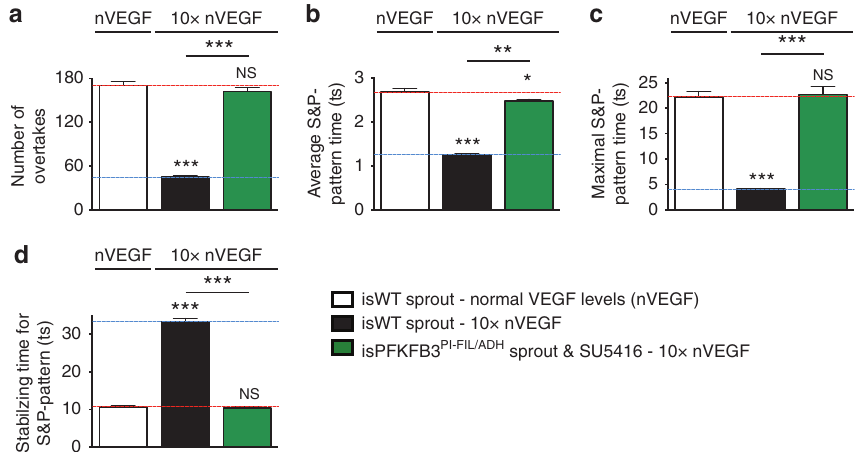
Figure 6 | Anti-VEGF is predicted to synergize with anti-metabolic therapy. ( a–d ) Number of overtakes ( a ), the average ( b ) and maximal time ( c ) during which a salt and pepper (S&P) pattern is maintained, and the time required to acquire a stable S&P pattern ( d ) for in silico WT (isWT) ECs in non-mosaic sprouts, in which PFKFB3 was pharmacologically blocked (isPFKFB3 PI ) simulated by modifying E FIL/ADH and blocking VEGF signalling (green; ‘isPFKFB3 PI-FIL/ADH sprout and SU5416’) in VEGF levels 10-fold higher than normal (10 (cid:2) nVEGF). The white and black bars represent a simulated isWT sprout in normal VEGF (nVEGF) and 10 (cid:2) nVEGF levels, respectively. The horizontal red and blue dotted lines show the particular values of an isWTsprout in normal and 10x VEGF levels, respectively. ts, timestep. Data are mean ± s.e.m.; n ¼ 50; NS, not significant, *** P o 0.001 versus isWT in nVEGF; the statistical significance between the black and green bars is also indicated (** P o 0.01, *** P o 0.001); Student’s t -test.